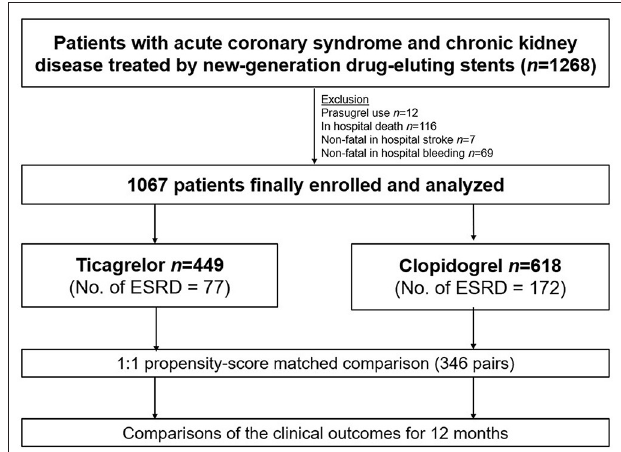
FIGURE 1 | Study flow diagram. ESRD, End Stage Renal